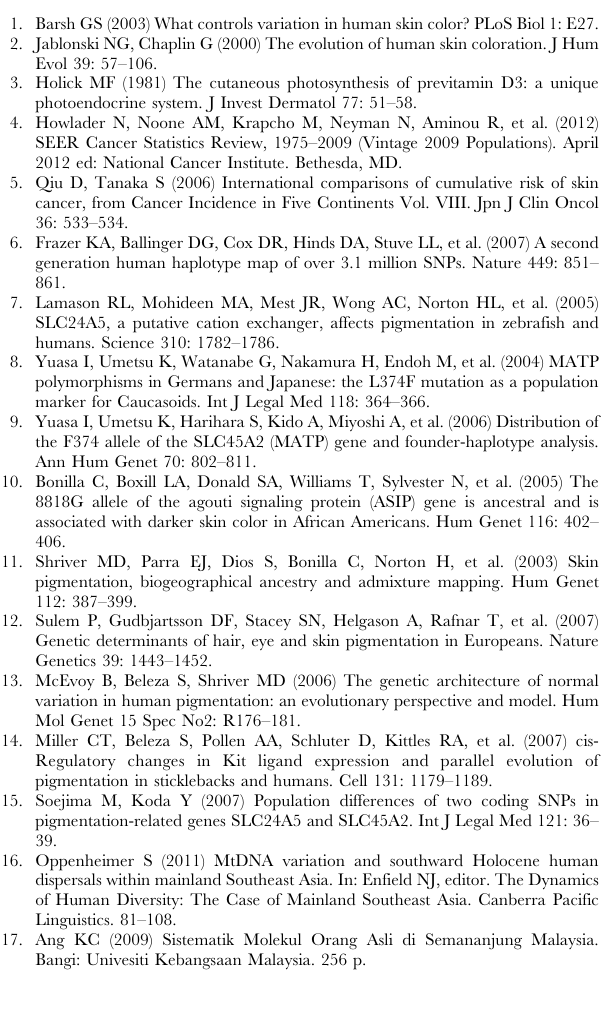
Table S1 Locations of sampling villages and their tribe and